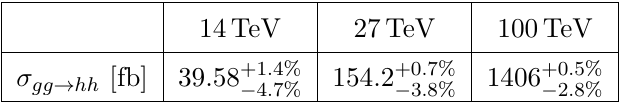
Table 1. The Standard Model cross-section for di-Higgs production via gluon-gluon fusion at several di(cid:11)erent center of mass energies, based on the \Born-projected approximation" in [44]. Scale uncertainties are shown as superscripts/subscripts.